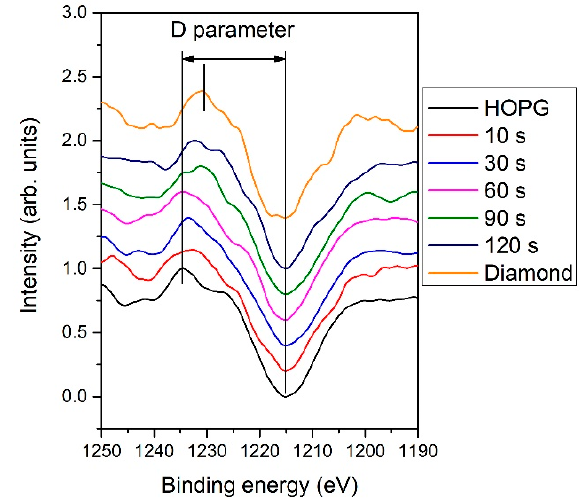
Figure 8. The first derivative of Auger CKLL spectra of N-doped carbon nanomesh deposited at various times and of highly-oriented pyrolytic graphite (HOPG) and diamond reference samples.